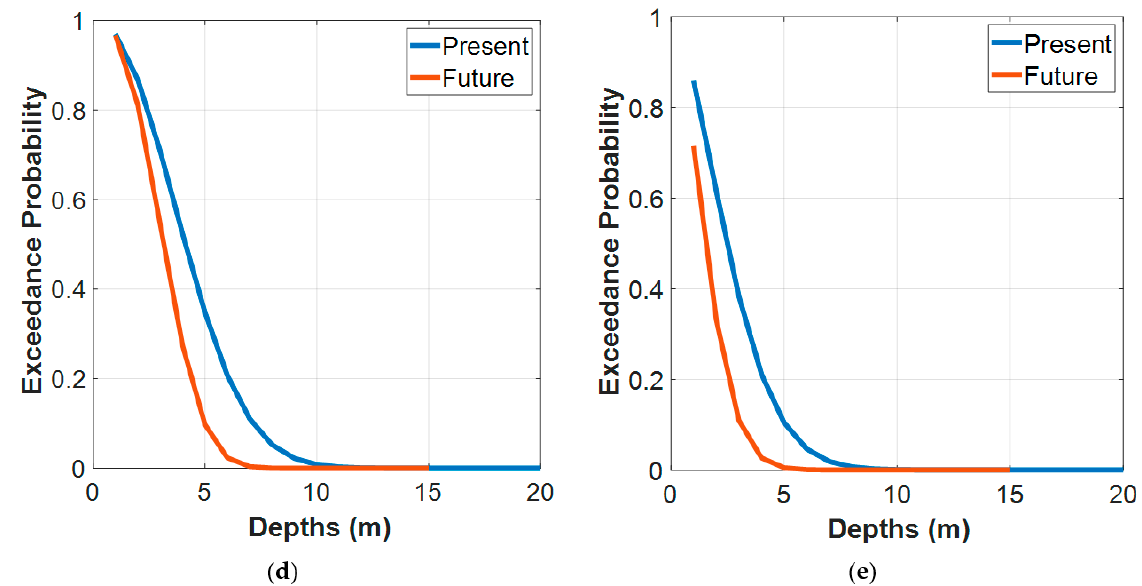
Figure 10. ( a ) Locations of sewage stations marked in red dots and the representative sewage pumping stations are marked in rectangular and the exceedance probabilistic distribution of the flooded depths at each representative pumping station: ( b ) station 1; ( c ) station 2; ( d ) station 3; ( e ) station 4. It is assumed to use one station if they are closed to each other; here there are a total of 4 representative sewage pumping stations: marked as pump 1 to pump 4 from top to bottom, shown in ( a ).